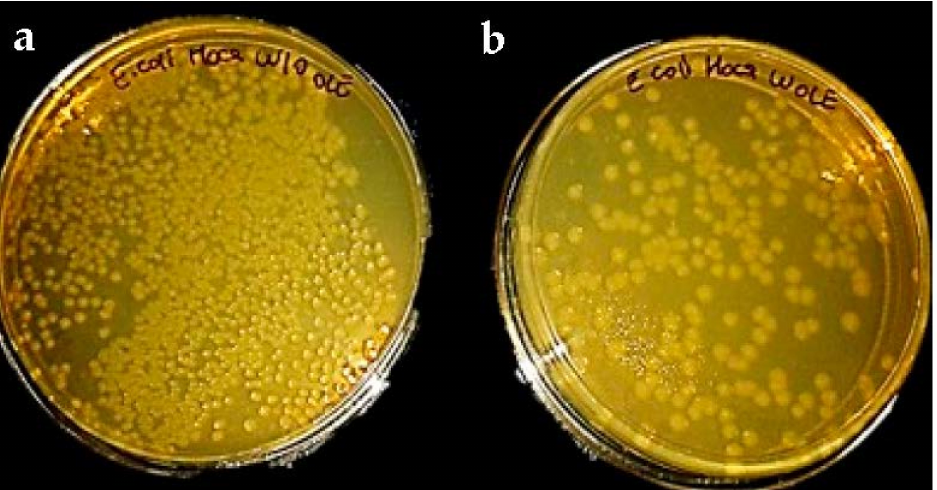
Figure 12. E. coli growth in the ( a ) eggshell membrane ( b ) OLE-loaded eggshell